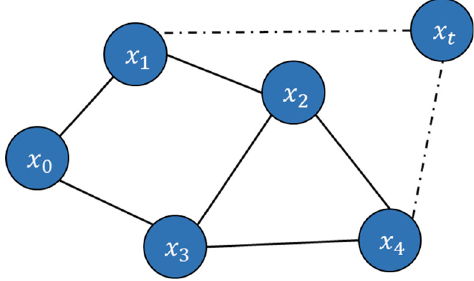
Figure 3. An example of a pose graph.